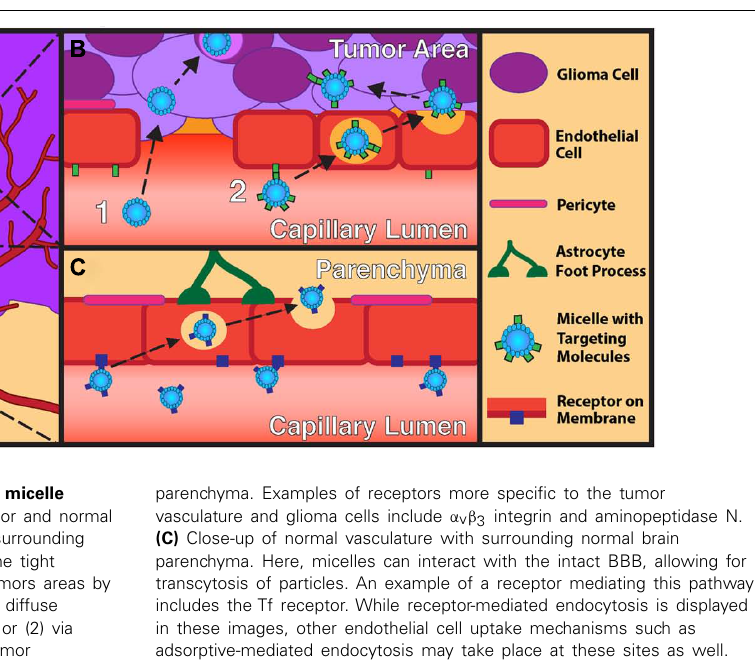
FIGURE 3 | Overview of GBM-targeting mechanisms for micelle nanoparticles. (A) Section of brain containing a GBM tumor and normal brain parenchyma. (B) Close-up of tumor vasculature and surrounding glioma cells. Here, the vasculature displays disruption of the tight junctions between endothelial cells. Micelles can target tumors areas by two main pathways: (1) via the EPR effect where micelles diffuse passively through the disrupted BBB to reach glioma cells or (2) via interaction with endothelial cells and transcytosis to the tumor